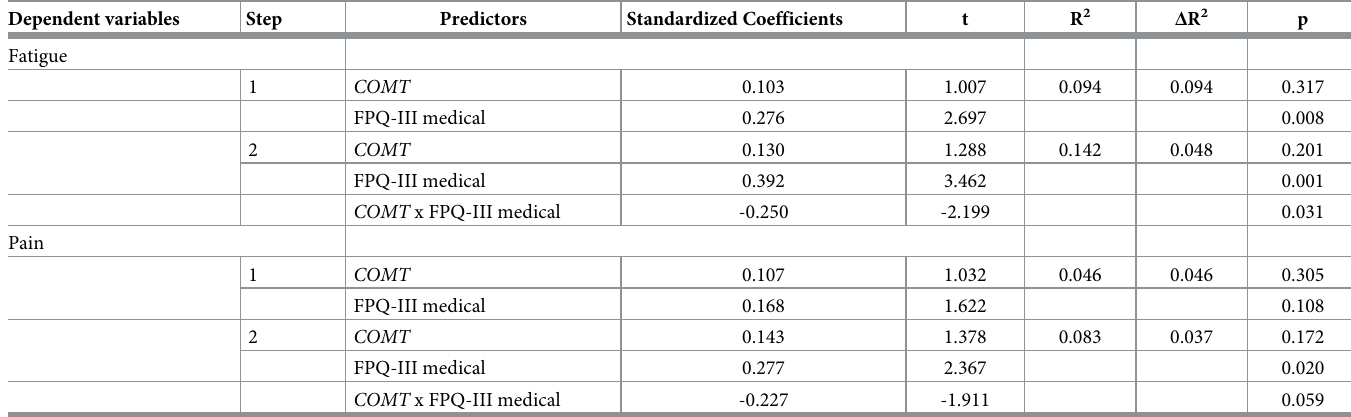
Table 4. Results of the multiple regression analysis for the interaction term ( COMT x FPQ-III medical) for fatigue and pain equation in individuals with fibromyalgia. Dependent variables